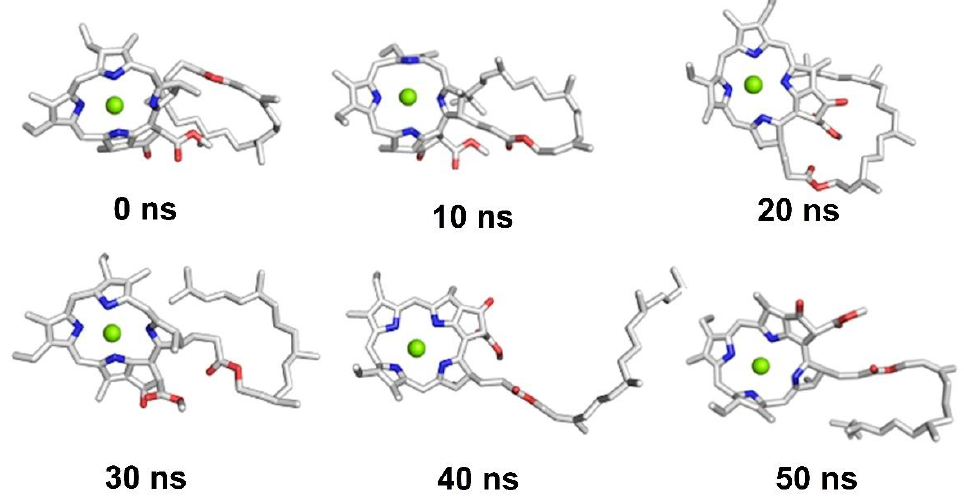
Figure 6. Snapshots for 50 ns of MD simulation of chl a 2 .